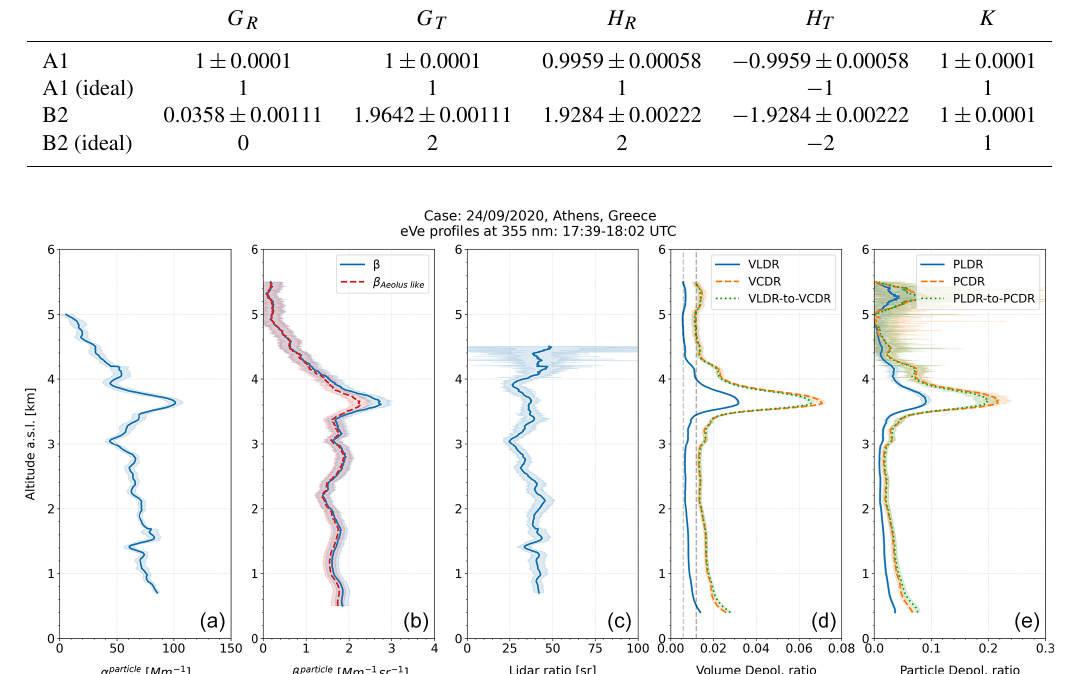
Table 3. The G , H , and K parameters with their uncertainties that were used for the retrieval of the VLDR and VCDR profiles on 24 September 2020. The ideal G , H , and K values for each configuration are also provided (Freudenthaler, 2016). G R